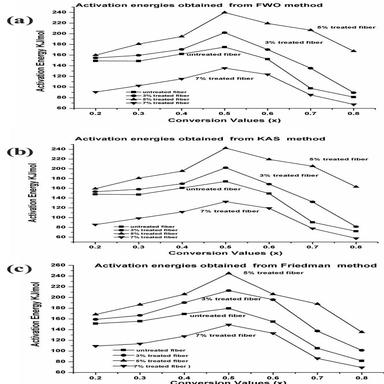
Variation of activation energy values with degree of conversion for untreated and various treated fibers, calculated from different methods.